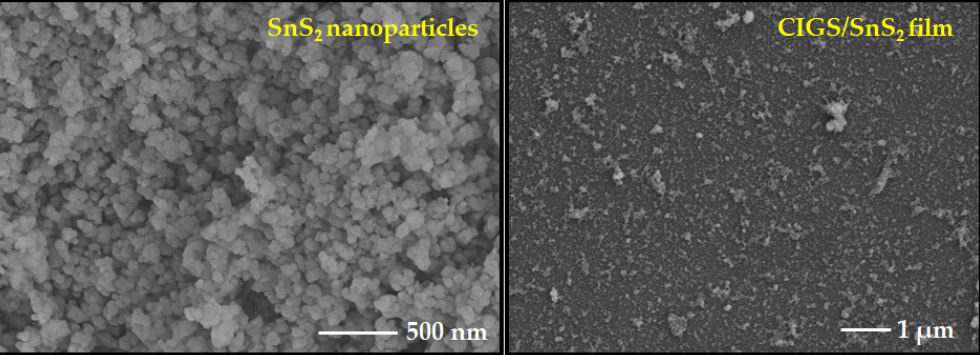
Figure 6. SEM surface image of as-synthesized SnS 2 nanoparticles and SnS 2 thin film.